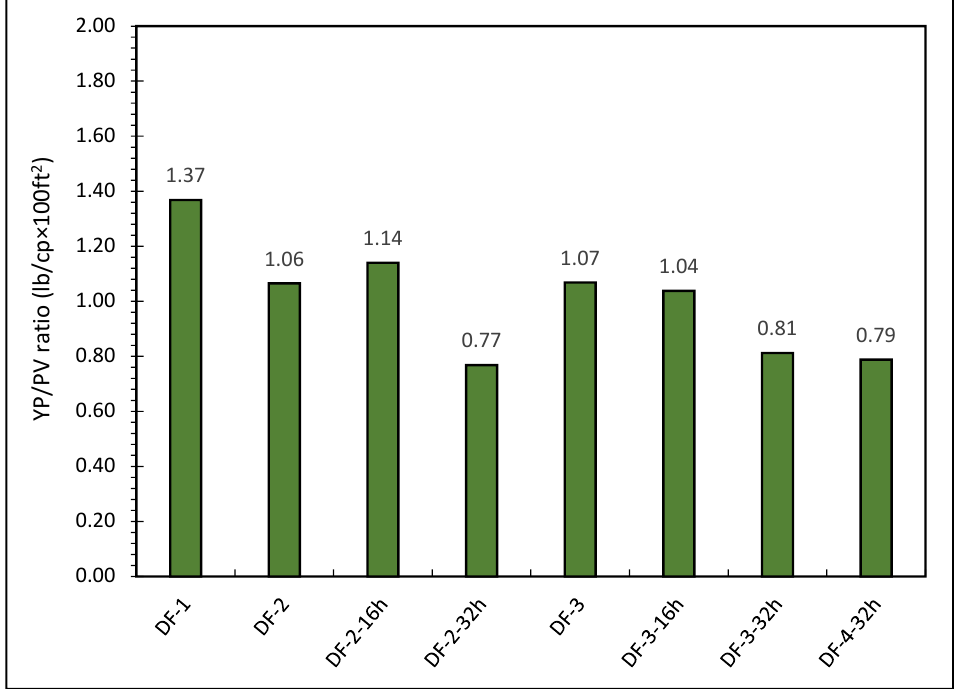
Figure 3. The YP/PV ratios of oil based drilling fluids. Gel strength describes the drilling fluid’s ability to suspend drill cuttings at static condition. The shear stress of a drilling fluid is measured with a viscometer at a low share rate (3 RPM) after being static for a length of time [10 s and 10 min in the API standard]. For the gel strength, 10 s and 10 min gel strengths were measured for all formulations. The 10-s and 10-min gel strengths for DF-1 formulation were 10 and 11 lb/100 ft 2 , respectively. For DF-2, the gel strength for 10 s and 10 min were the same at 20 lb/100 ft 2 . After hot rolling DF-2 formulation for 16 h, the gel strength for 10 s and 10 min were 20 lb/100 ft 2 and 23 lb/100 ft 2 , respectively. It showed that DF-2 maintained gel strengths after 16 h of hot rolling but after 32 h of hot rolling, DF-2 gel strengths for 10 s and 10 min were decreased significantly to 10 lb/100 ft 2 and 12 lb/100 ft 2, , respectively. The addition of rheology modifier and oil wetter did not bring much change in gel strength before hot rolling as noticed in DF-3. After hot rolling for 16 h, 10-s and 10 min gel strengths for DF-3 increased to 20 and 30 lb/100 ft 2 from 17 and 19 lb/100 ft 2 respectively. After 32 h of hot rolling, slight reduction in gel strengths was noticed compared with gel strength after 16 h, but the values are still high compared to gel strength before hot rolling. Similarly, a reduction in gel strength is observed in DF-4 after 32 h hot rolling. For DF-4, the values of 10-s and 10 min gel strengths were less when compared to DF-3 after 32 h of hot rolling. Marinating the gel strength even after 32 h of hot rolling was mainly due to the rheology modifier and the oil wetter. The gel strength results of the different drilling fluid formulations are given in Figure 4.